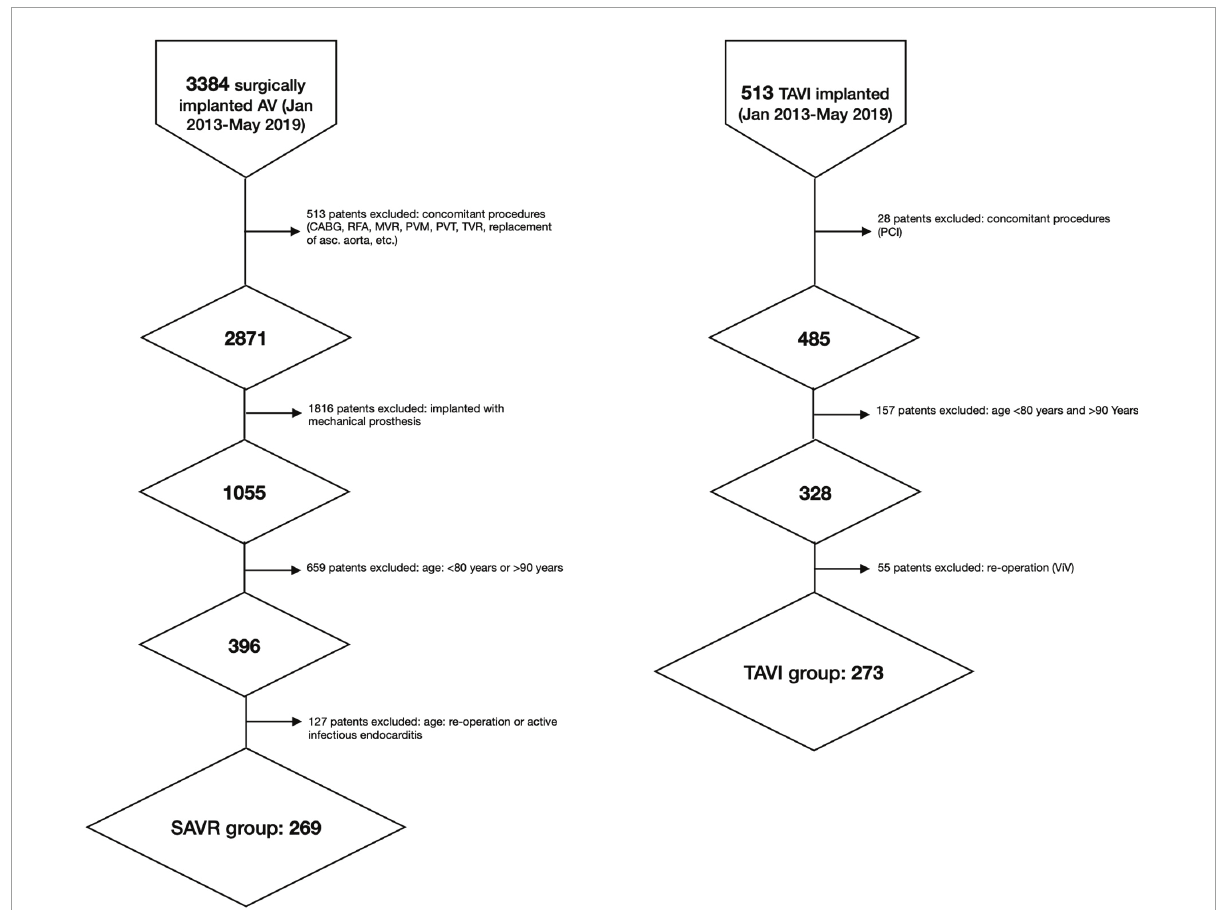
FIGURE1 Flow-chart. asc, ascending; AV, aortic valve; CABG, coronary artery bypass graft; RFA, radiofrequency ablation; MVR, mitral valve replacement; PCI, percutaneous coronary intervention; PVT, plasty of tricuspid valve, PVM, plasty of mitral valve; TVR, tricuspid valve replacement; SAVR, surgical aortic valve replacement; TAVI, transcatheter aortic valve implantation.